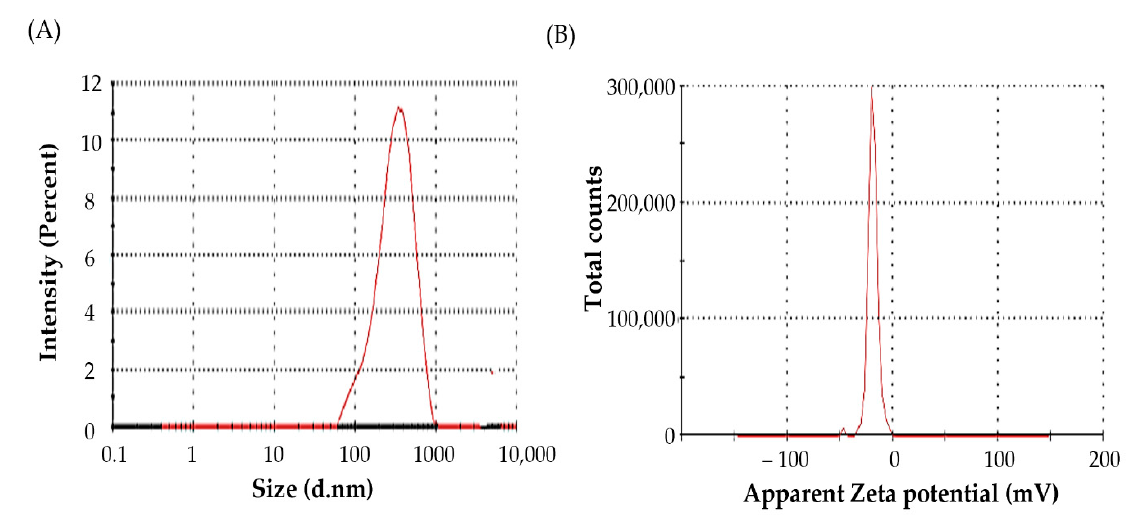
Figure 4. ( A ) Particle size; and ( B ) zeta potential of silver nanoparticles.